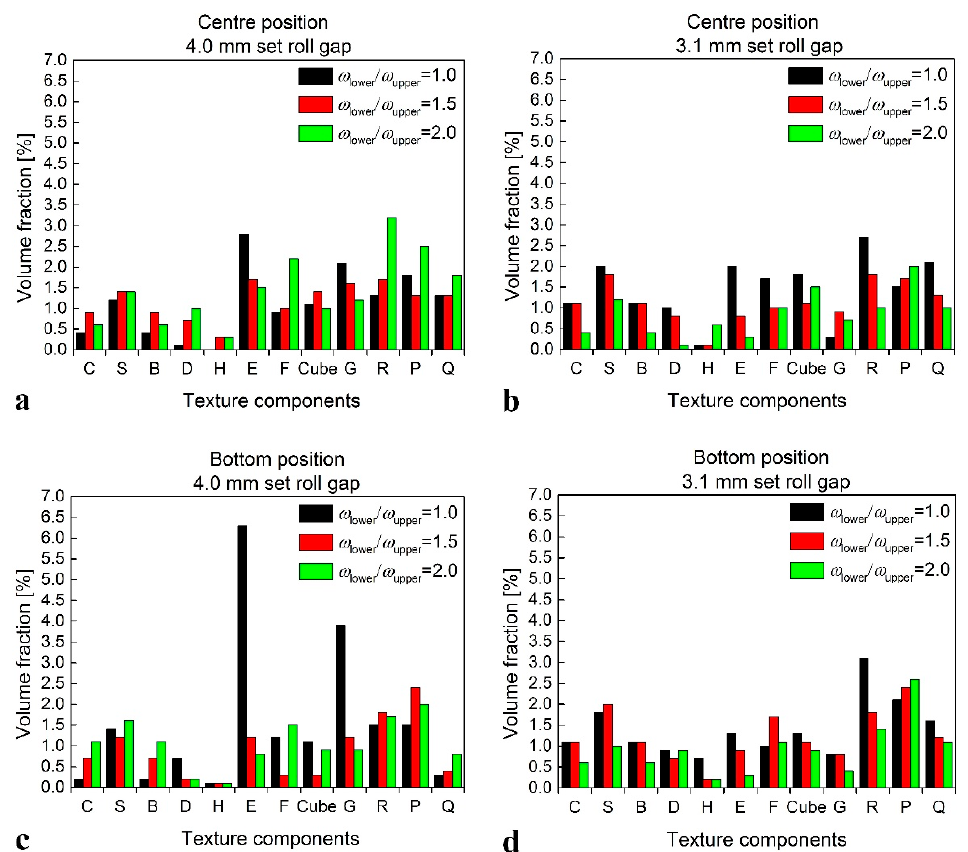
Figure 7. Volume fraction of texture components in heat-treated samples for 4.0 mm set roll gap and centre position ( a ), 3.1 mm set roll gap and centre position ( b ), 4.0 mm set roll gap and bottom position ( c ) and 3.1 mm set roll gap and centre position ( d ).